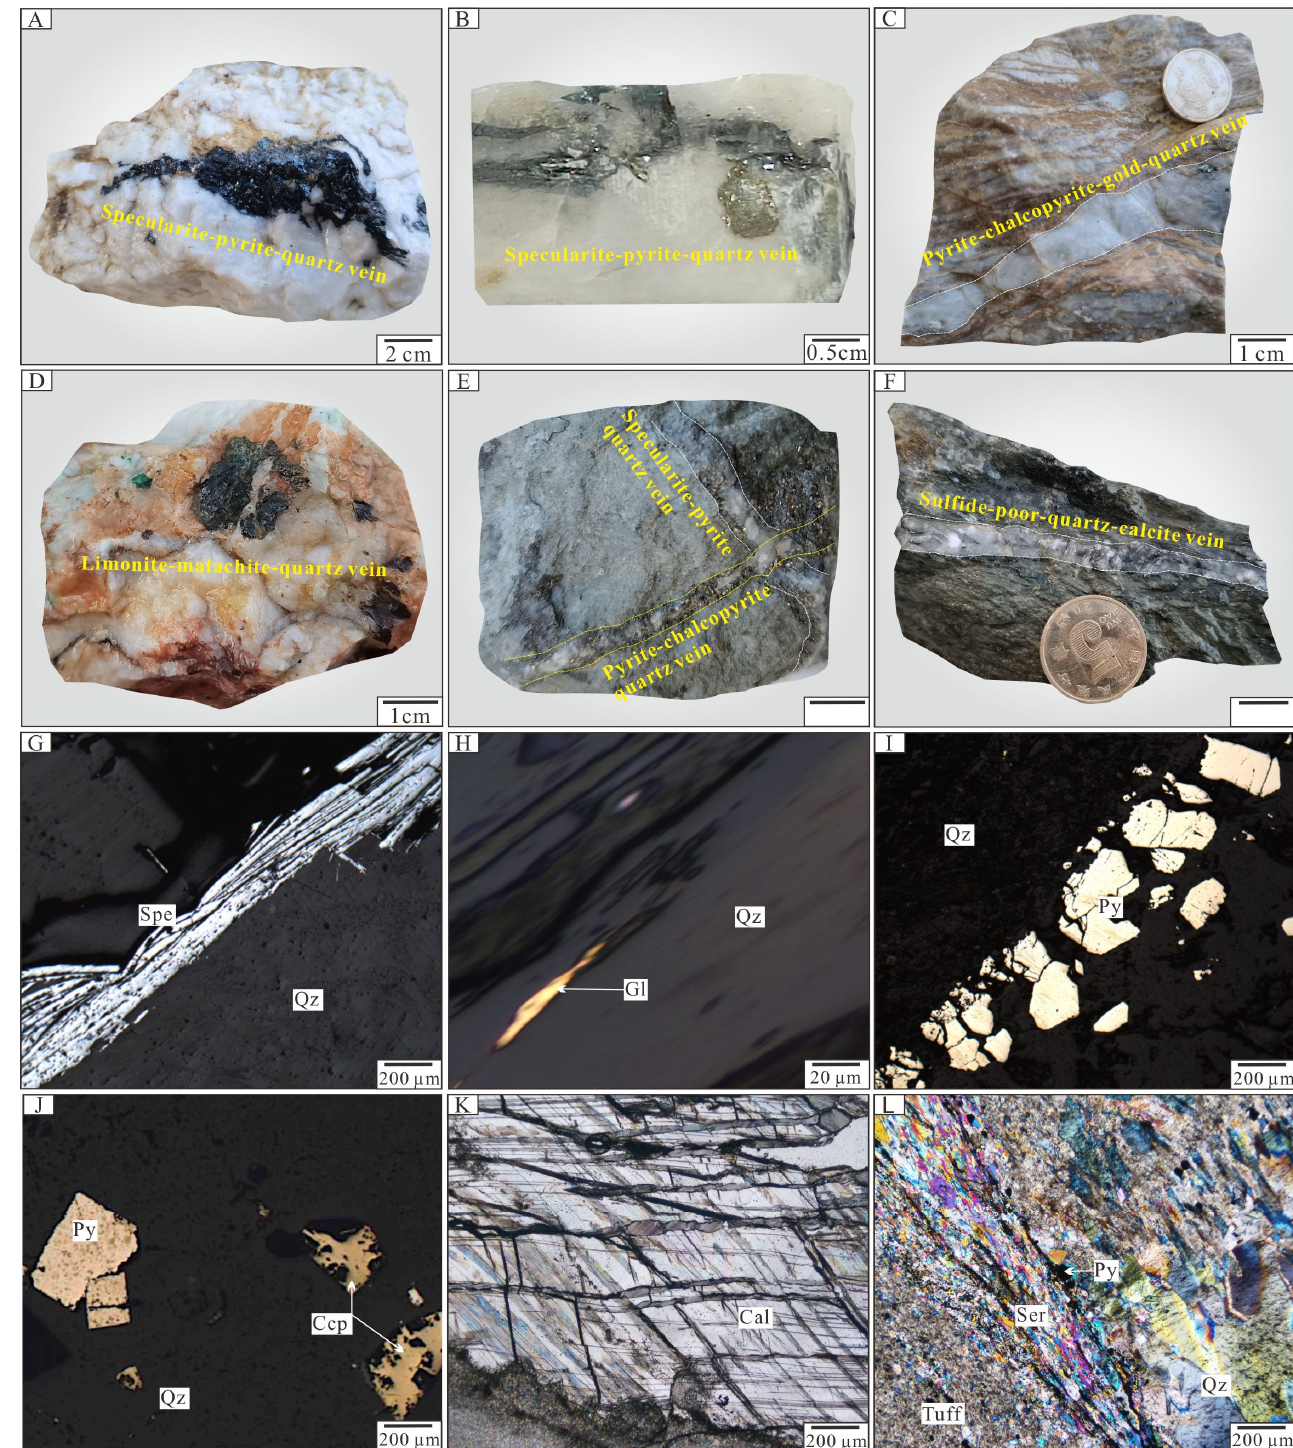
Figure 3. Photographs showing ore fabrics and mineral assemblages of the Harla gold deposit. ( A , B ) Specularite–pyrite–quartz vein; ( C ) pyrite–chalcopyrite–gold–quartz vein; ( D ) limonite–malachite–quartz vein; ( E ) pyrite–chalcopyrite–quartz vein crosscutting Specularite–pyrite–quartz vein; ( F ) sulfide-poor quartz–calcite vein; ( G ) blade-shaped specularite; ( H ) flaky native gold in quartz grain; ( I ) pyrite veinlet; ( J ) euhedral pyrite and anhedral chalcopyrite; ( K ) carbonation in wall rocks; ( L ) sericitization in wall rocks. Abbreviations: Qz—quartz; Ser—sericite; Cal—calcite; Spe—specularite; Gl—native gold; Py—pyrite; Ccp—chalcopyrite.